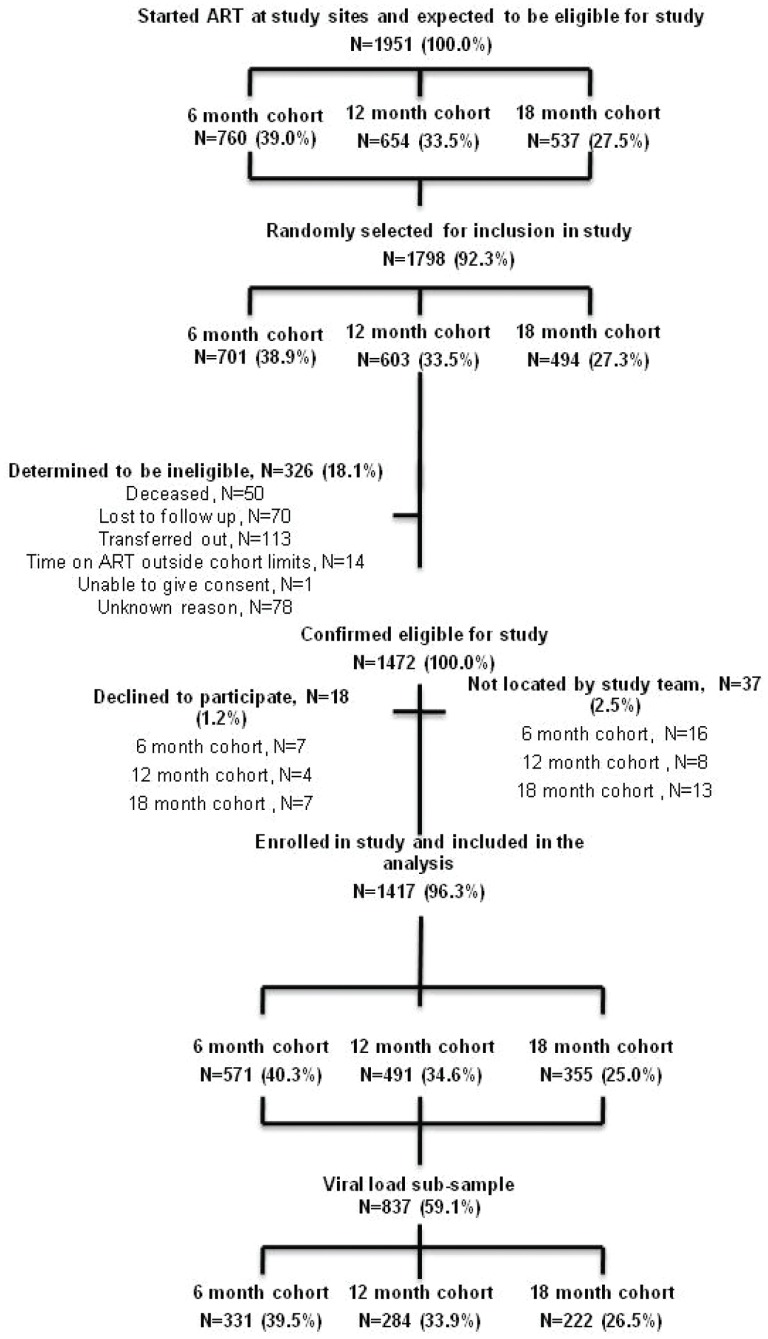
Participant selection and recruitment.